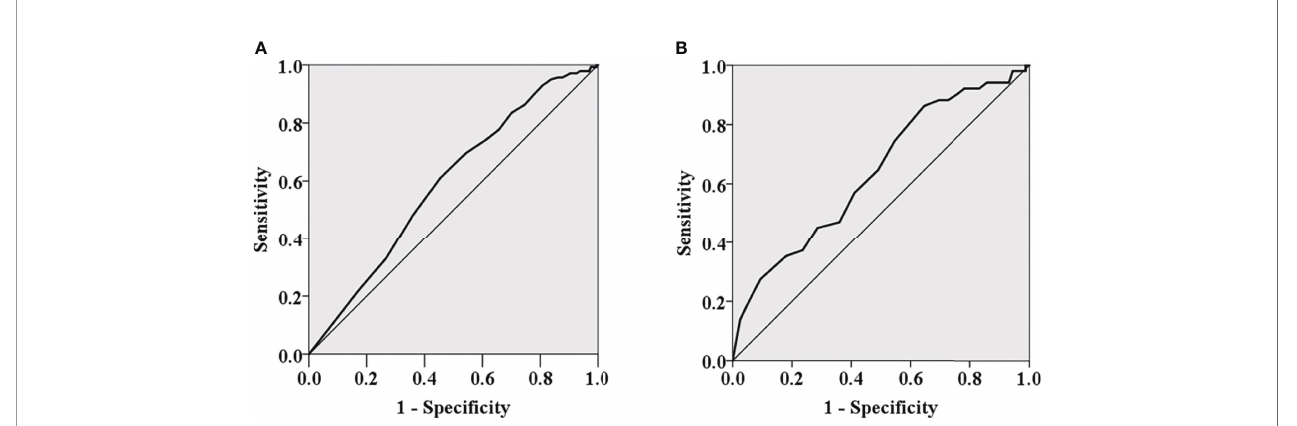
FIGURE 1 | The ROC curves of the number of metastatic lymph nodes for predicting excellent response for the entire population (A) and pN1b PTC patients (B) .